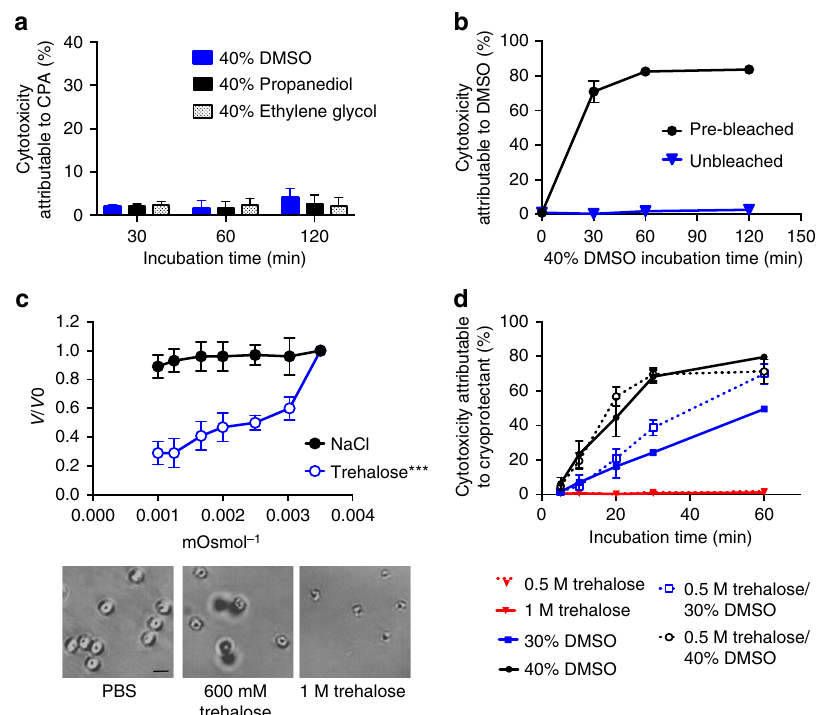
Fig. 1 C. parvum oocyst response to CPAs. a Oocysts were incubated with high concentrations of several common CPAs. As no signi fi cant increase in oocyst toxicity was observed over long incubation intervals (30 – 120 min), it was concluded that the oocysts are impermeable to CPAs. Values indicate means and error bars indicate standard deviation ( n = 3). b Hypochlorite treatment was used as a method to increase oocyst permeability to CPAs. Bleached and unbleached oocysts were incubated with 40% DMSO and cytotoxicity was quanti fi ed by fl ow cytometry using PI exclusion. Both bleached and unbleached oocysts incubated with PBS served as a normalizing control. While unbleached oocysts exhibited no toxicity, bleached oocysts incubated with DMSO exhibited substantial toxicity over the observed period (30 – 120 min), suggesting CPA permeability was achieved. Values indicate means and error bars indicate standard deviation ( n = 3). c Oocyst volume was measured by fl ow cytometry to characterize dehydration induced by hyperosmotic solutions of NaCl and trehalose ( V , estimated oocyst volume; V o, volume of control oocysts). While NaCl had insigni fi cant effect on volume (one-way ANOVA ; p = 0.90, f = 0.33, d f = 20), signi fi cant dehydration was observed using trehalose (one-way ANOVA; p < 0.0001, f = 18.65, d f = 20), a common extracellular CPA. Data met requirements of normality (Wilk Shapiro test; p > 0.29 and p > 0.85 for all NaCl and trehalose concentrations, respectively) and homoscedasticity (Brown – Forsythe test; p = 0.80 and p = 0.88 for NaCl and trehalose, respectively) for inclusion in ANOVA analysis. Values indicate means and error bars indicate standard deviation. Panels show a signi fi cant decrease in cell volume in response to increasing concentrations of trehalose compared to the untreated PBS control ( n = 3). Micrographs show oocysts exposed to trehalose or PBS as indicated. Scale indicates 5 µ m. d The kinetics